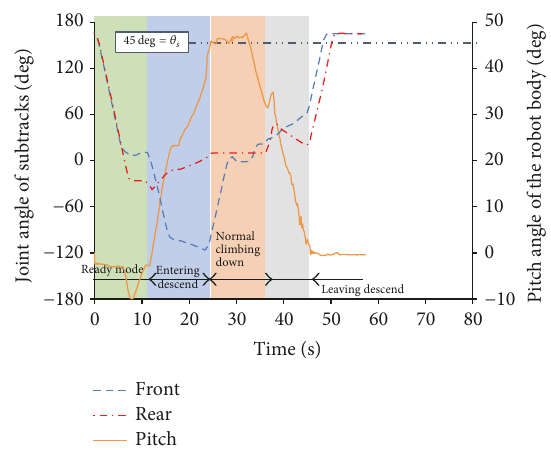
Figure29:Dataprofilefor 𝜃 𝑓 , 𝜃 𝑟 , 𝜃 𝑝 ( 𝜃 𝑠 =45 ∘ , 𝑝 =200